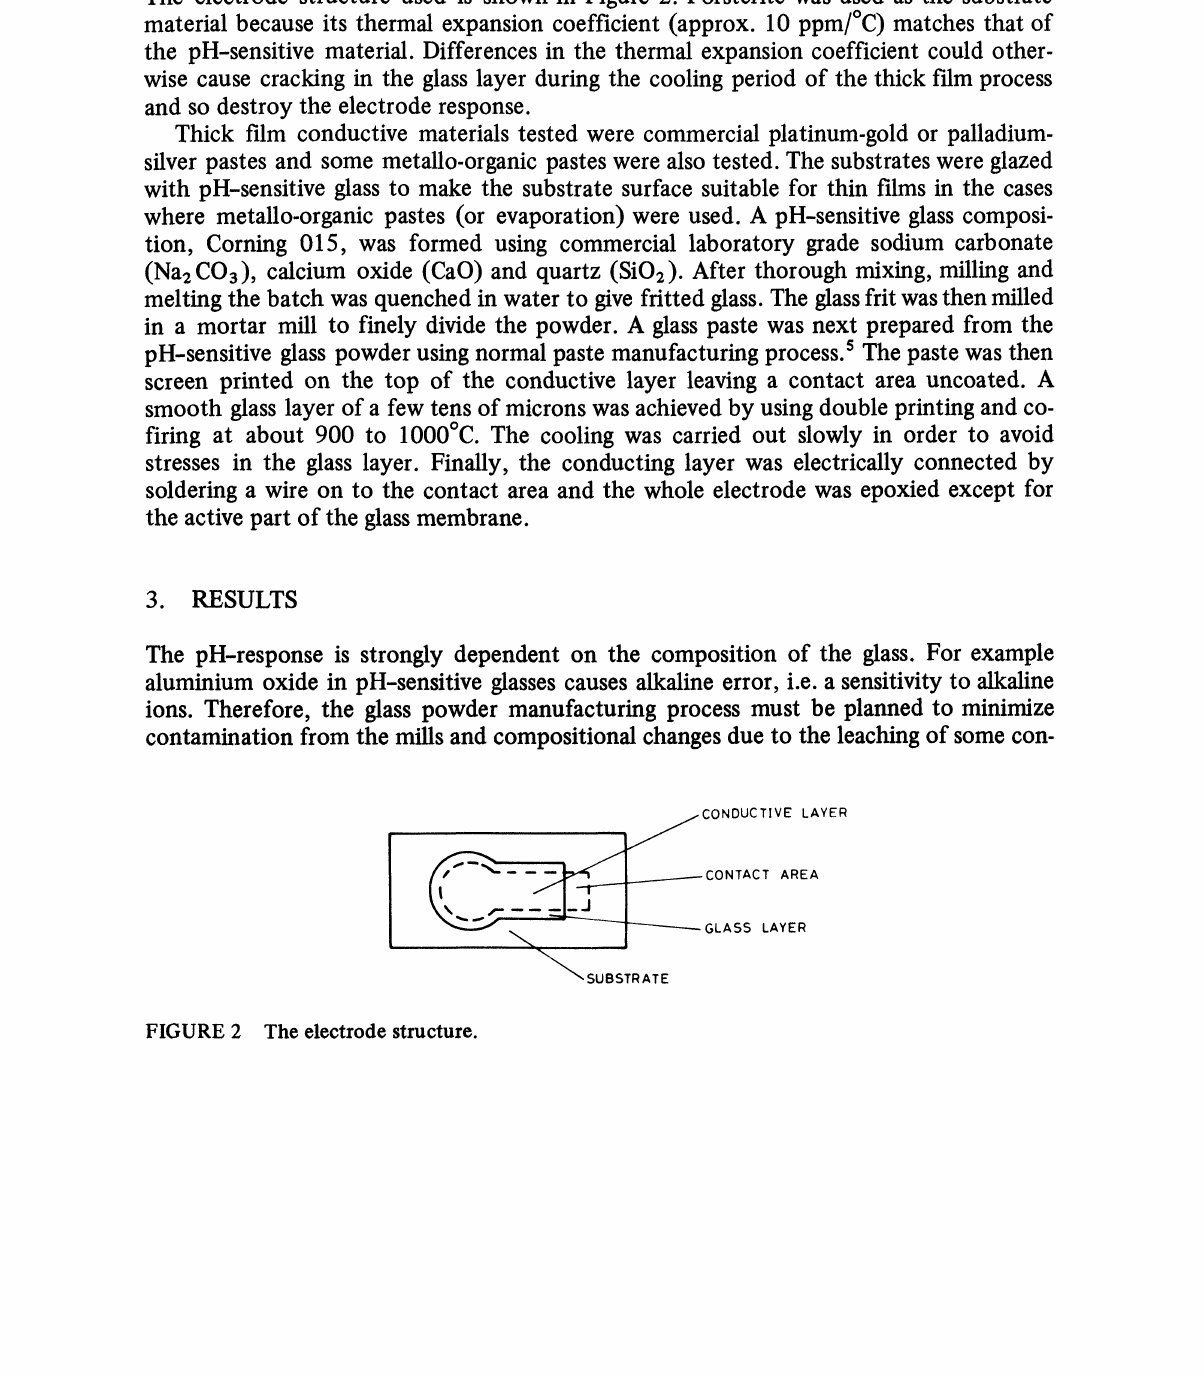
FIGURE 2 The electrode